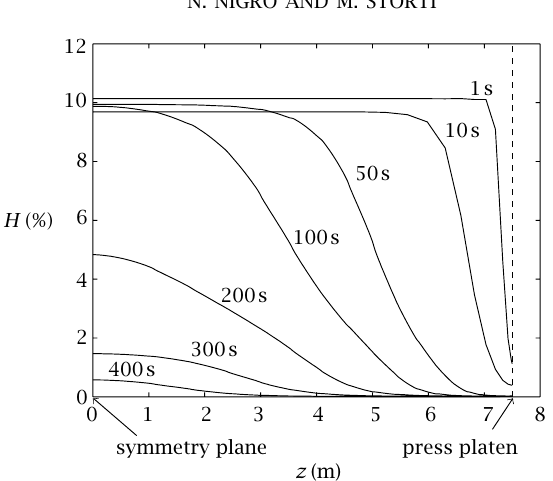
Figure 5.5 . Axial moisture content profile at r = R = 0 . 2828m.